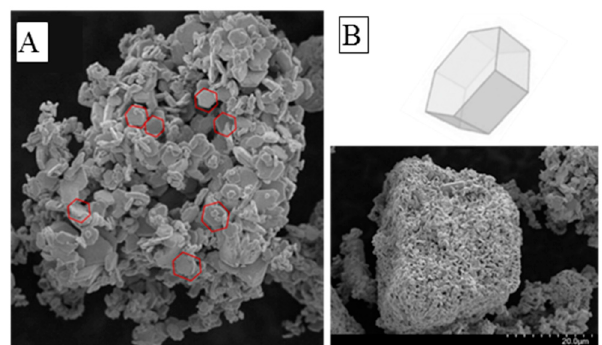
Figure 2. ( A , B ) Scanning electron microscopy (SEM) image of the as-prepared MAIPb (methylammonium lead iodide perovskite) .